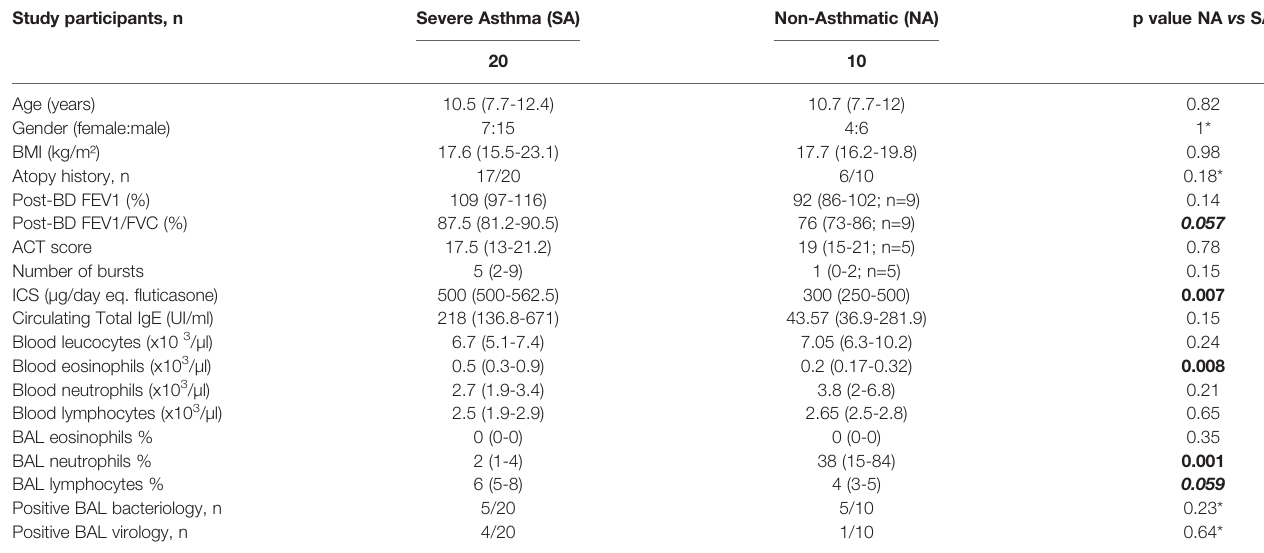
TABLE 1 | Demographic and clinical characteristics of the children with SA and the non-asthmatic disease controls (chronic pulmonary in fl ammation, NA). Study participants,